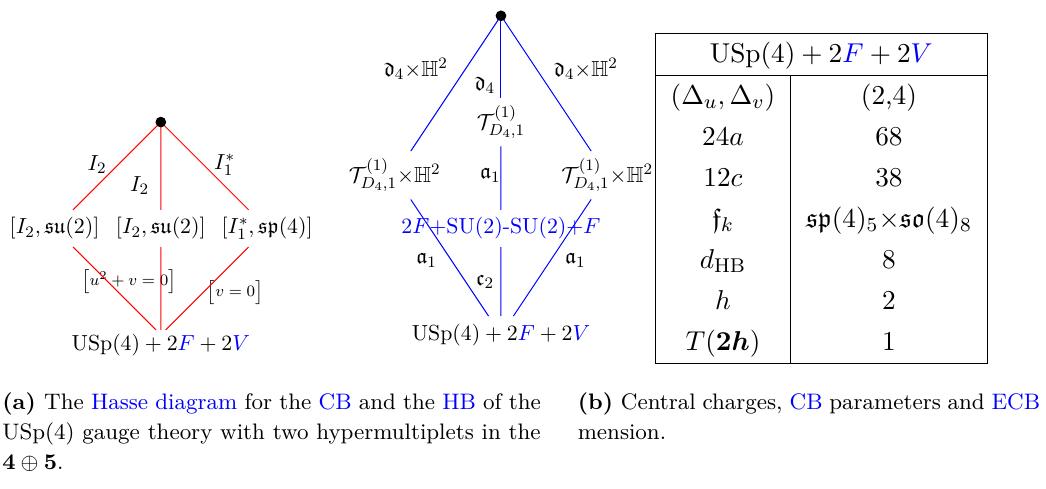
other SU(2) the hyper in the 4 has no massless component while those in the 5 contribute a hyper in the adjoint of SU(2) . The result is that we expect three knotted strata,